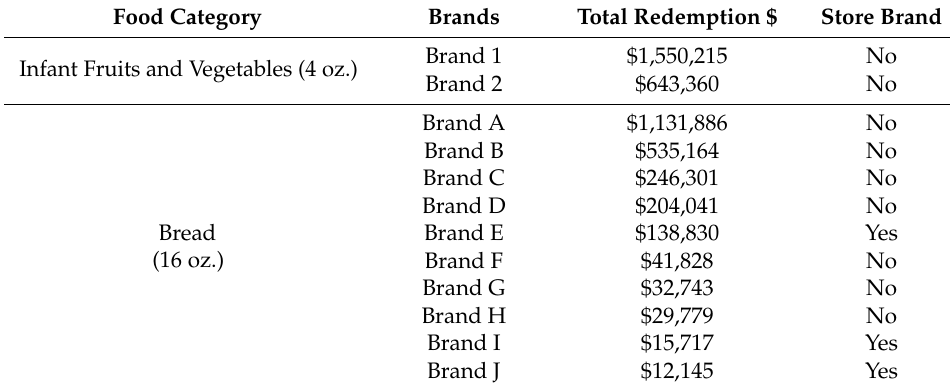
Table 1. Distribution of major brands ( ≥ 1% WIC redemption share) in infant fruits & vegetables and bread. Food Category Brands Total Redemption $ Store Brand Infant Fruits and Vegetables (4 oz.)